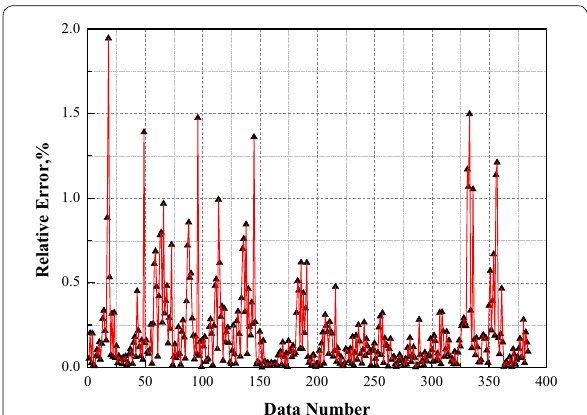
Fig. 7 Relative error between the target and output shear